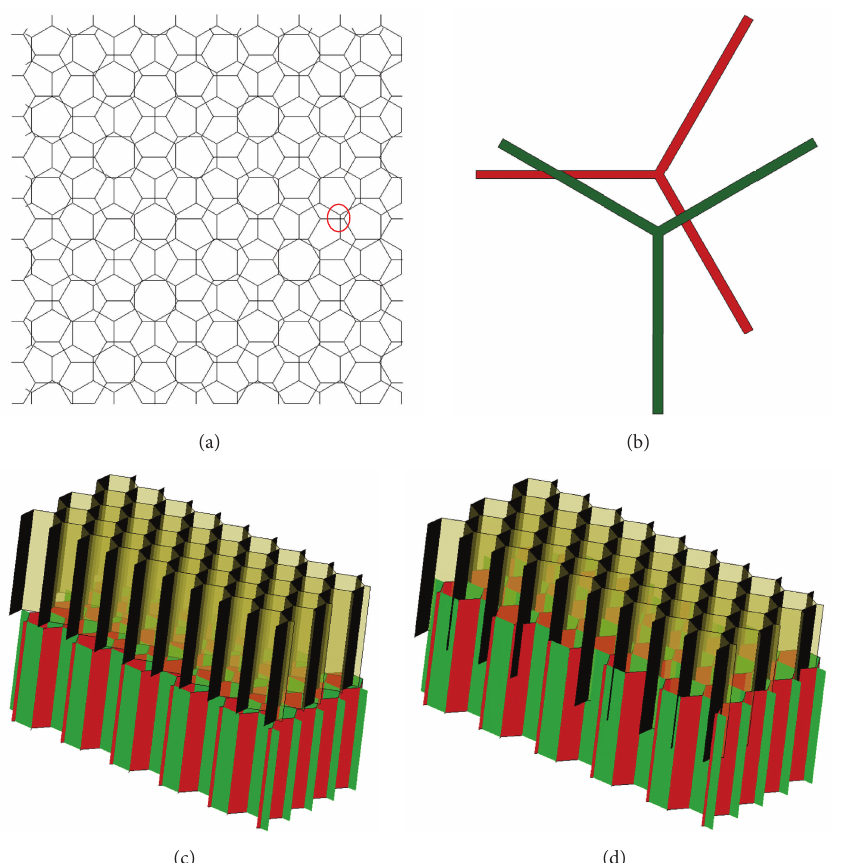
Figure 6: Schematic of CHAH sample of top view and vertical section cut-out view. (a) Top view; (b) amplification of the red circle area in (a); (c) partial section view with 𝑆 = 0 mm; (d) partial section view with 𝑆 = 5 mm.